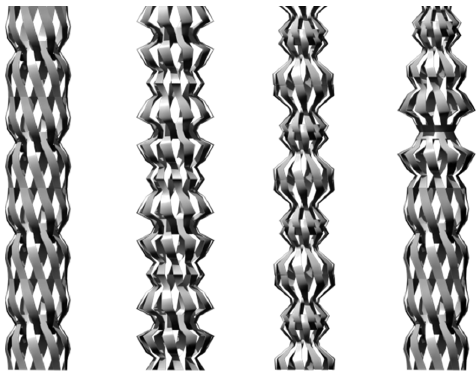
Figure 15. Possible combination of basket structures for column-like elements.